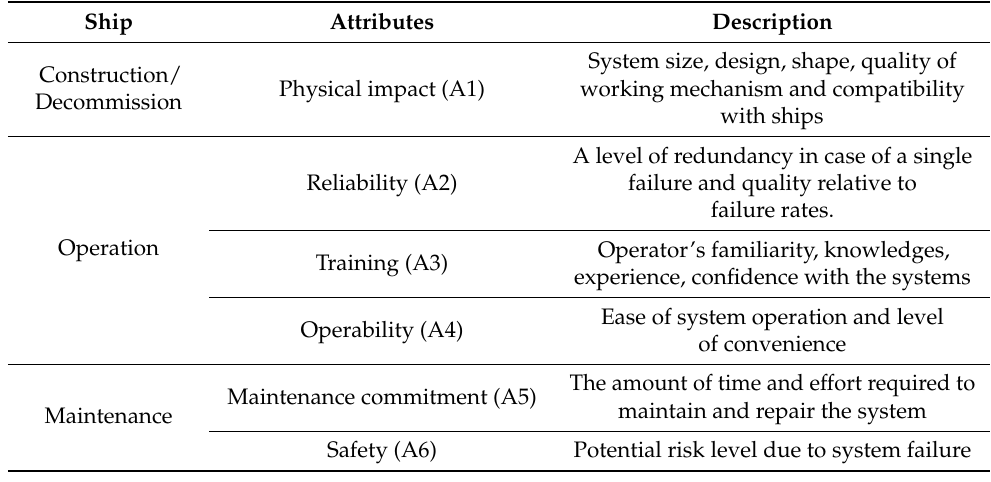
Table 4. Attributes applied to fuzzy-TOPSIS for technical impact assessment on scrubber